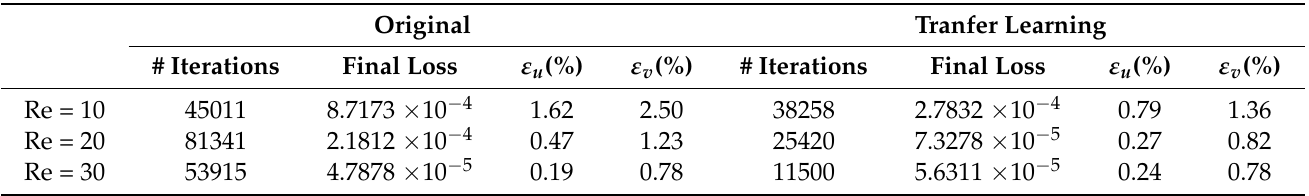
Table 4. A comparison of the performances in re-training the DNNs using original and transfer learning